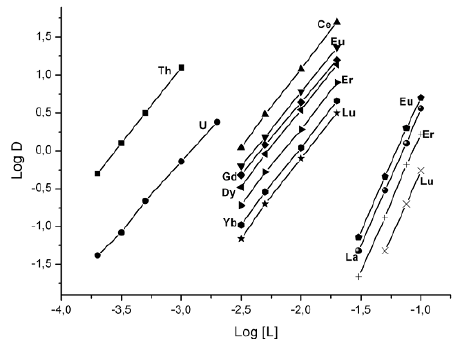
Figure 4. The effect of the concentration of extractants 1 and 3 in 1,2-dichloroethane on the extraction of Ln(III), Th(IV) and U(VI) from 3 M HNO solutions. 3